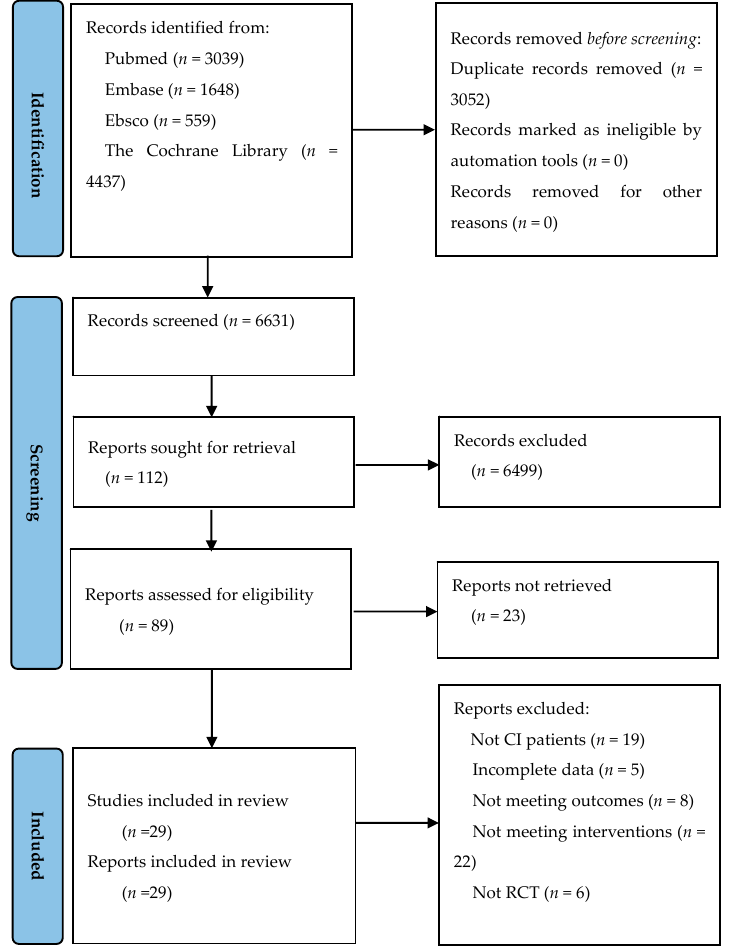
Figure 1. PRISMA flow diagram of included studies.